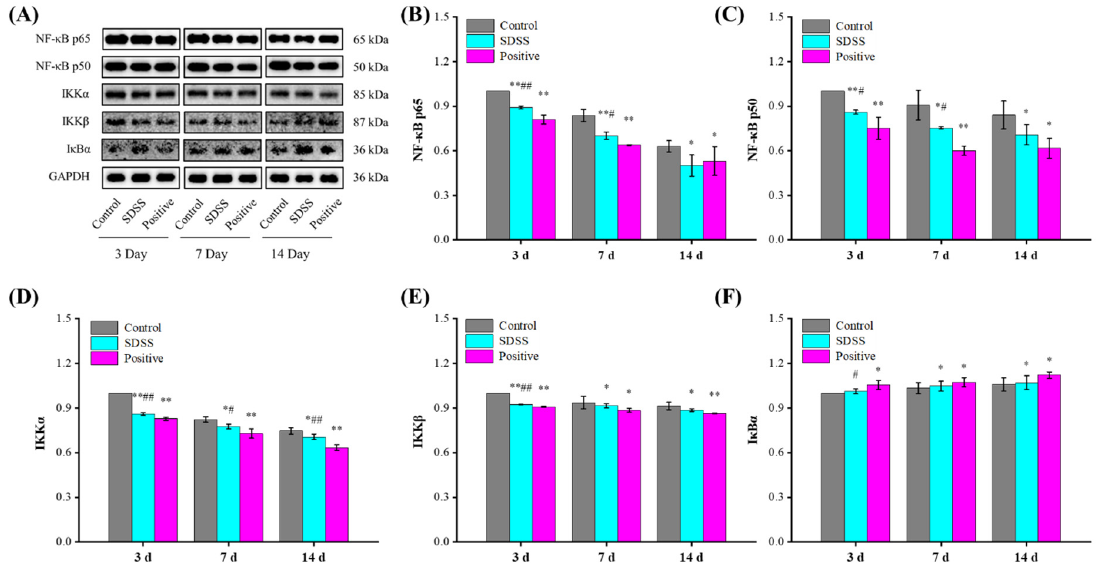
Figure 7. Effect of SDSS on the protein levels of the NF- κ B pathway ( n = 5). ( A ) Western blot; the protein expression levels of NF- κ B p65 ( B ), NF- κ B p50 ( C ), IKK α ( D ), IKK β ( E ), and I κ B α ( F ) levels. * p < 0.05, ** p < 0.01 when compared to the control group. # p < 0.05, ## p < 0.01 when compared to the positive group.